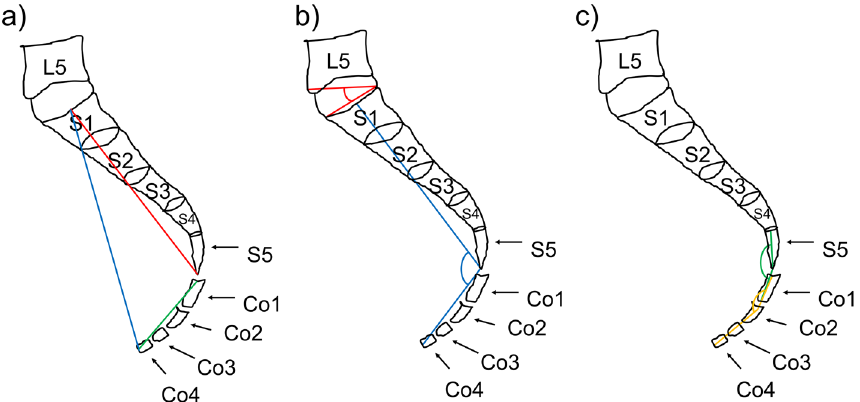
Figure 1. Coccygeal parameters. ( a ) Straight lengths. Green, coccygeal straight length; red, sacral straight length; blue, sacrococcygeal straight length. ( b ) Angles of the sacrum. Red, lumbosacral angle; blue, sacrococcygeal angle. ( c ) Angles of the coccyx. Green, sacrococcygeal joint angle; orange, intercoccygeal angle.